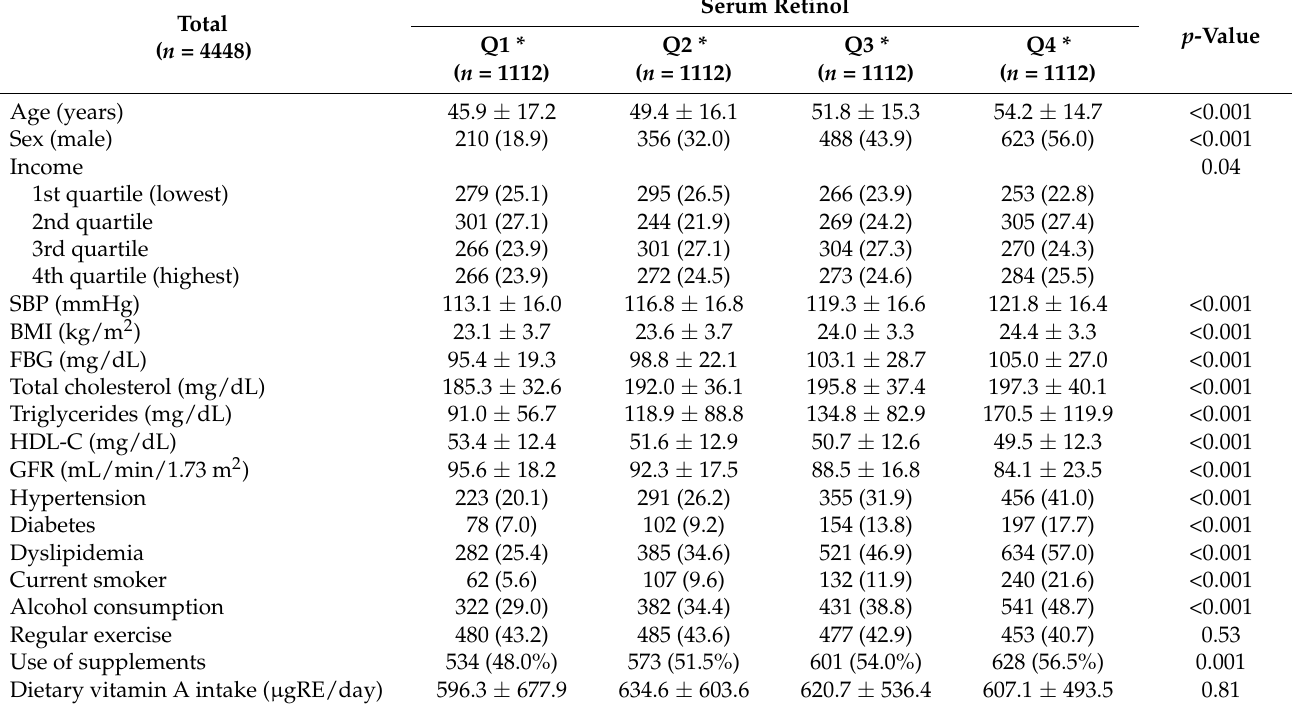
Table 1. Characteristics of subjects according to quartile group for serum